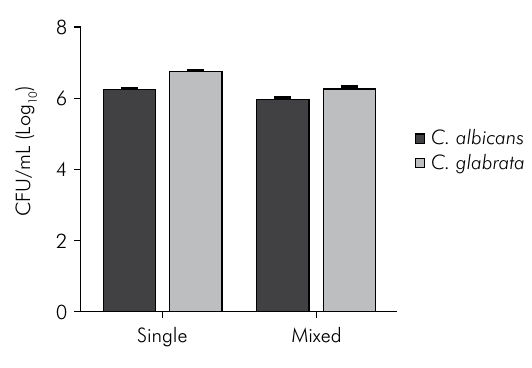
Figure 2. Mean values and standard deviation (n = 10) of CFU/mL (log ) of C. albicans and C. glabrata , organized 10 in single and mixed biofilms. Student t-test. C. albicans counts: statistically significant difference between biofilm formed by C. albicans and biofilm formed by C. albicans + C. glabrata (p < 0.0001). C. glabrata counts: statistically significant difference between biofilm formed by C. glabrata and biofilm formed by C. albicans + C. glabrata (p <